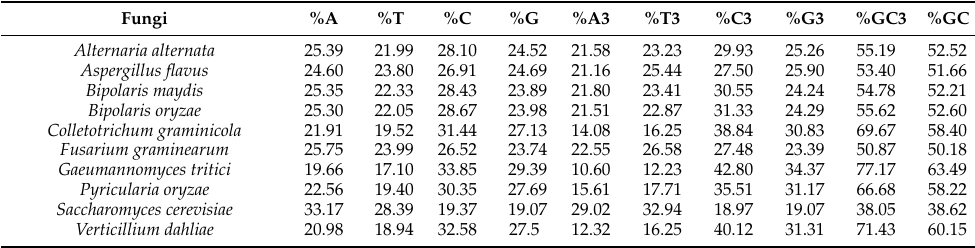
Table 2. The mean nucleotide composition of zinc binuclear cluster family CDS sequences in As- comycetes plant pathogenic fungi and model yeast